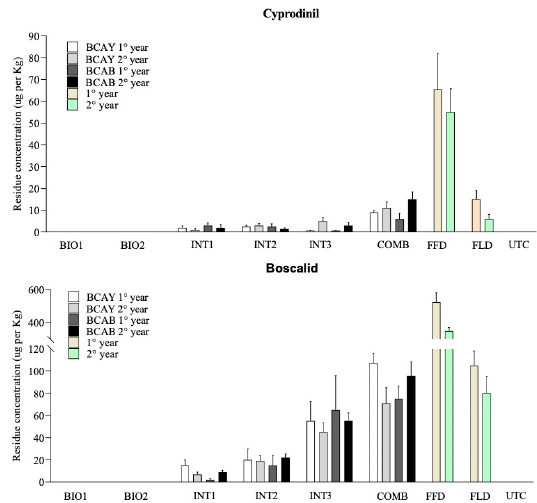
Figure 3. Residues of the fungicides boscalid and cyprodinil (µg/kg) in plum fruit after two years of field trials in plum orchard in which the plants were treated following six different disease management strategies: Biological, in which the BCAs (the yeast Papiliotrema terrestris PT22AV (BCAY) or the commercial biofungicide Serenade Max ® based on Bacillus subtilis strain QST 713 (BCAB), were applied alone in five (BIO1) or seven (BIO2) treatments; Integrated, INT1, INT2 and INT3, consisted of the application from the beginning of the growing season of one, two or three treatments respectively with the chemical fungicides boscalid or cyprodinil applied alternately and each strategy was followed by BCAs applications until fruit harvest; Combined (COMB), in